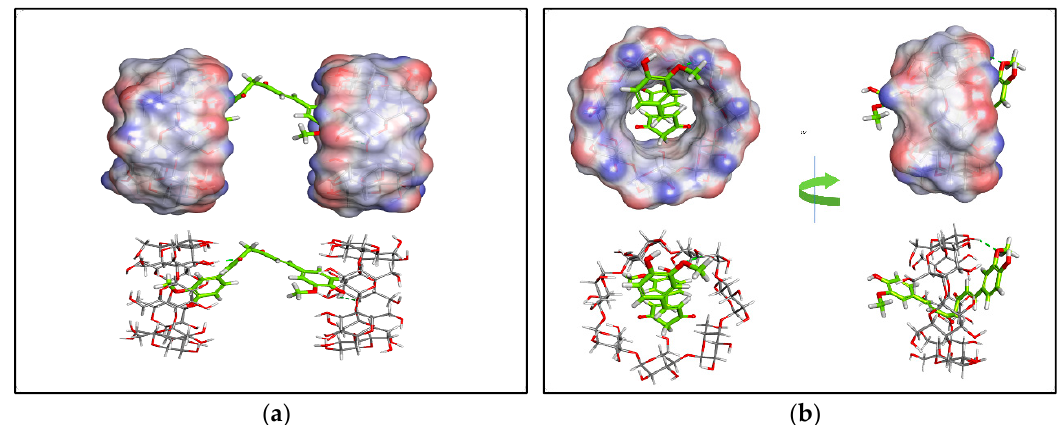
Figure 3. The binding orientation of curcumin in both complexation schemes with β‐ cyclodextrin. ( a ) The complexation scheme involves a 1:2 ratio of curcumin: β‐ cyclodextrin; ( b ) The second possible complexation scheme involves a 1:1 ratio. The upper panels show the surface representation of β‐ cyclodextrin, while curcumin is shown as sticks. In the lower panels, β‐ cyclodextrin is shown as sticks to enable better visualization of intermolecular hydrogen bonds (dashed green lines).